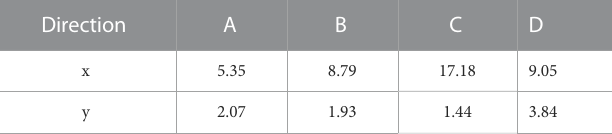
TABLE 10 Increase of residual stress with ultrasonic frequency from 28 kHz to 40 KHz